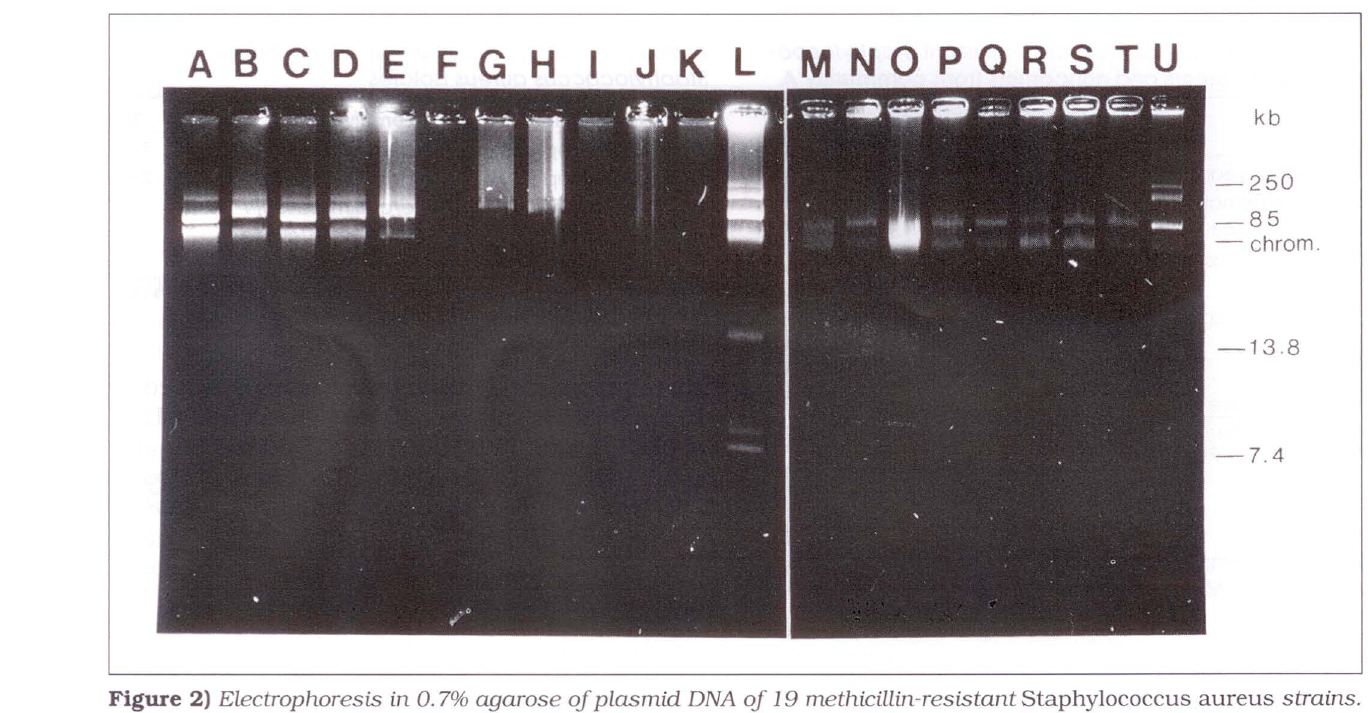
Figure 2) Electrophoresis in 0. 7% agarose of plasmid DNA of 19 methicillin-resistant Staphylococcus aureus strains. Lane A shows strain 1 a; lane B strain 1 b; lane C strain 2; lanes D-K strains 4-11, respectively; and lanes M-T strains 12-19, respectively. Lanes Land U contain marker plasmids of Bacillus thuringiensis, with molecular weights shown on the right ( 17). kb Kilobases; chrom.